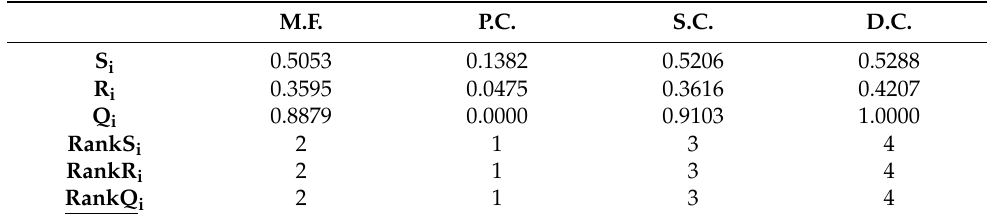
Table 12. S i , R i and Q i values and relevant alternatives’ ranking, based on the AHP-VIKOR model. M.F.